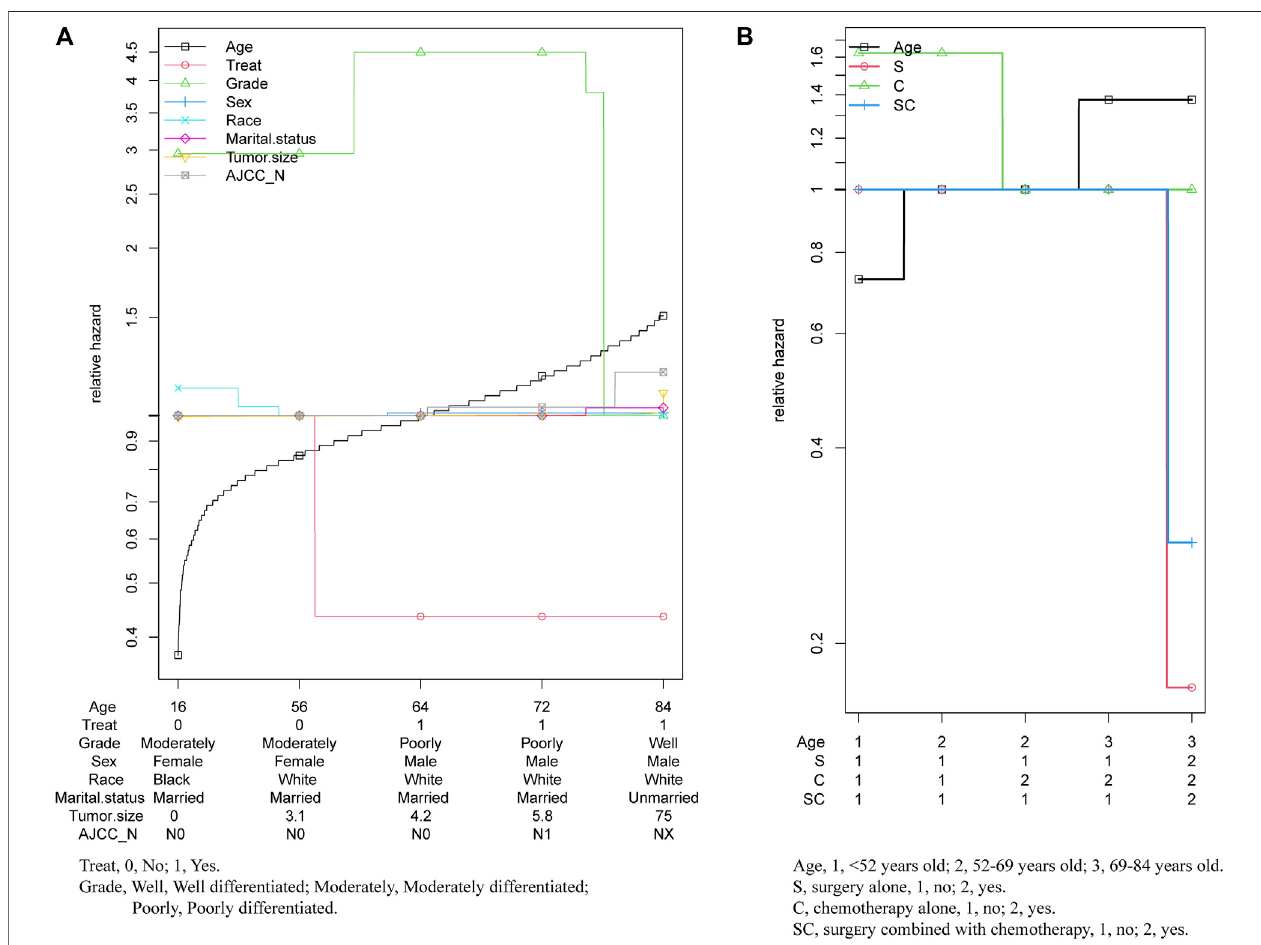
FIGURE 6 | Relative hazard ratio of multivariables in patients with pancreatic cancer metastasis to liver.